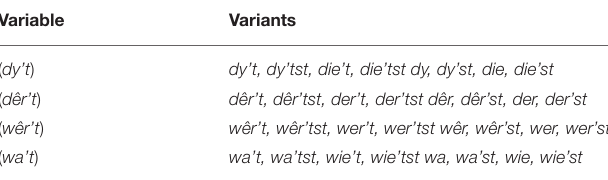
TABLE 3 | Results for CLD3 and textcat ( n =